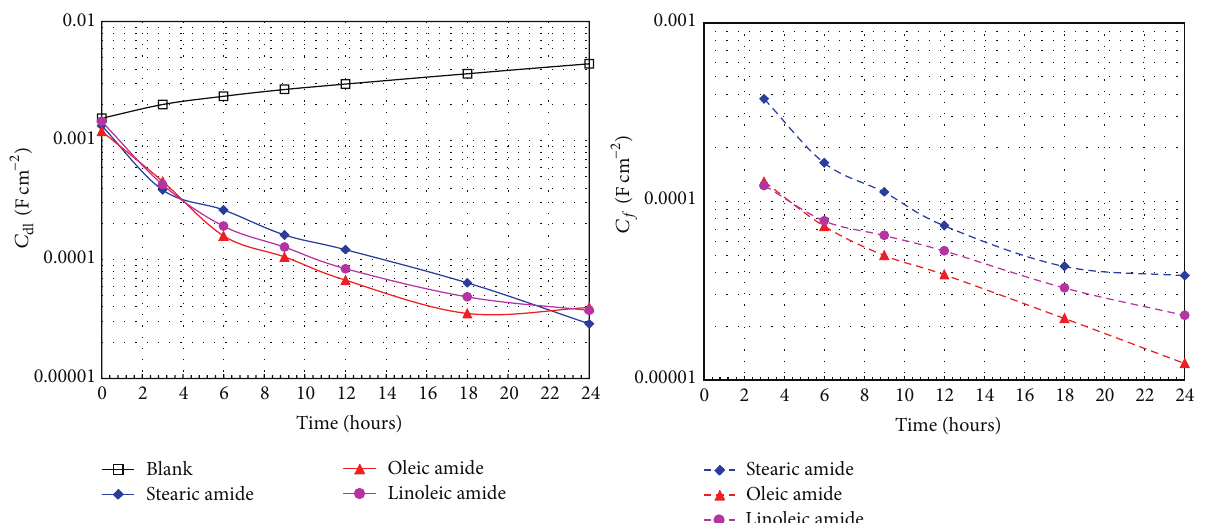
Figure 13: 𝐶 and 𝐶 𝑓 variation against time for carbon steel with and without fatty-amides. dl